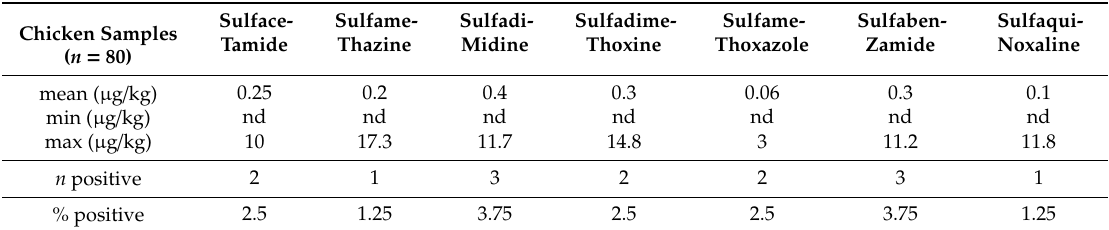
Table 4. Occurrence in the 80 chickens samples of sulfonamides.